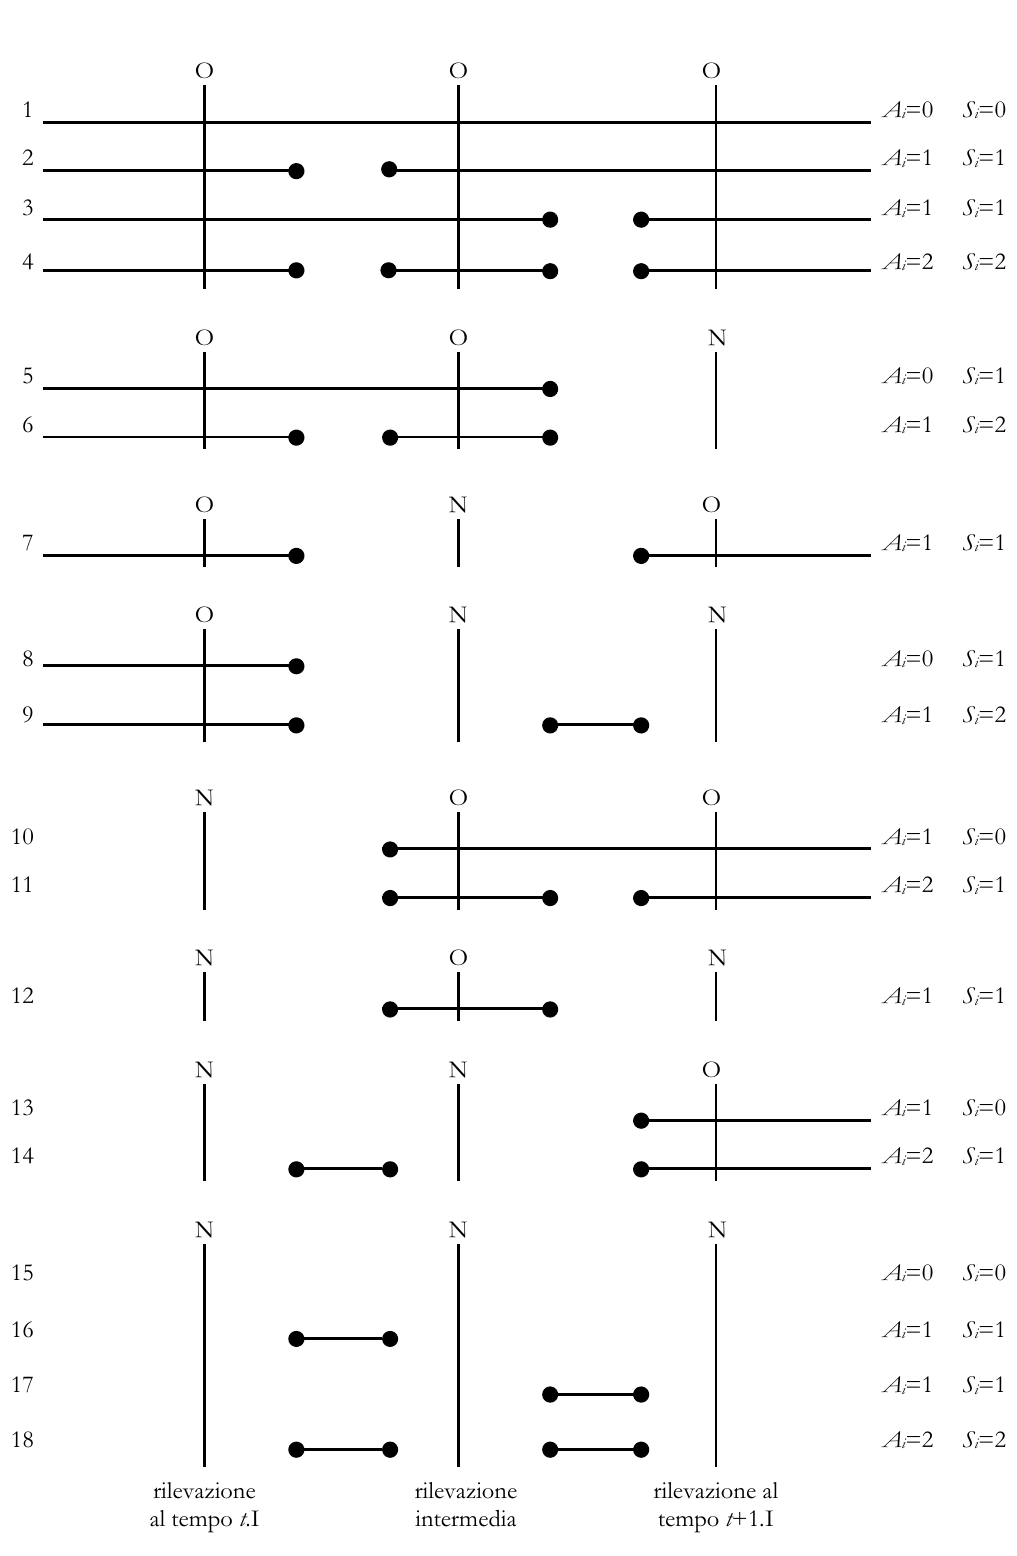
Figura 2 – Schema per l’identificazione degli episodi lavorativi e delle transizioni dall’abbinamento a tre